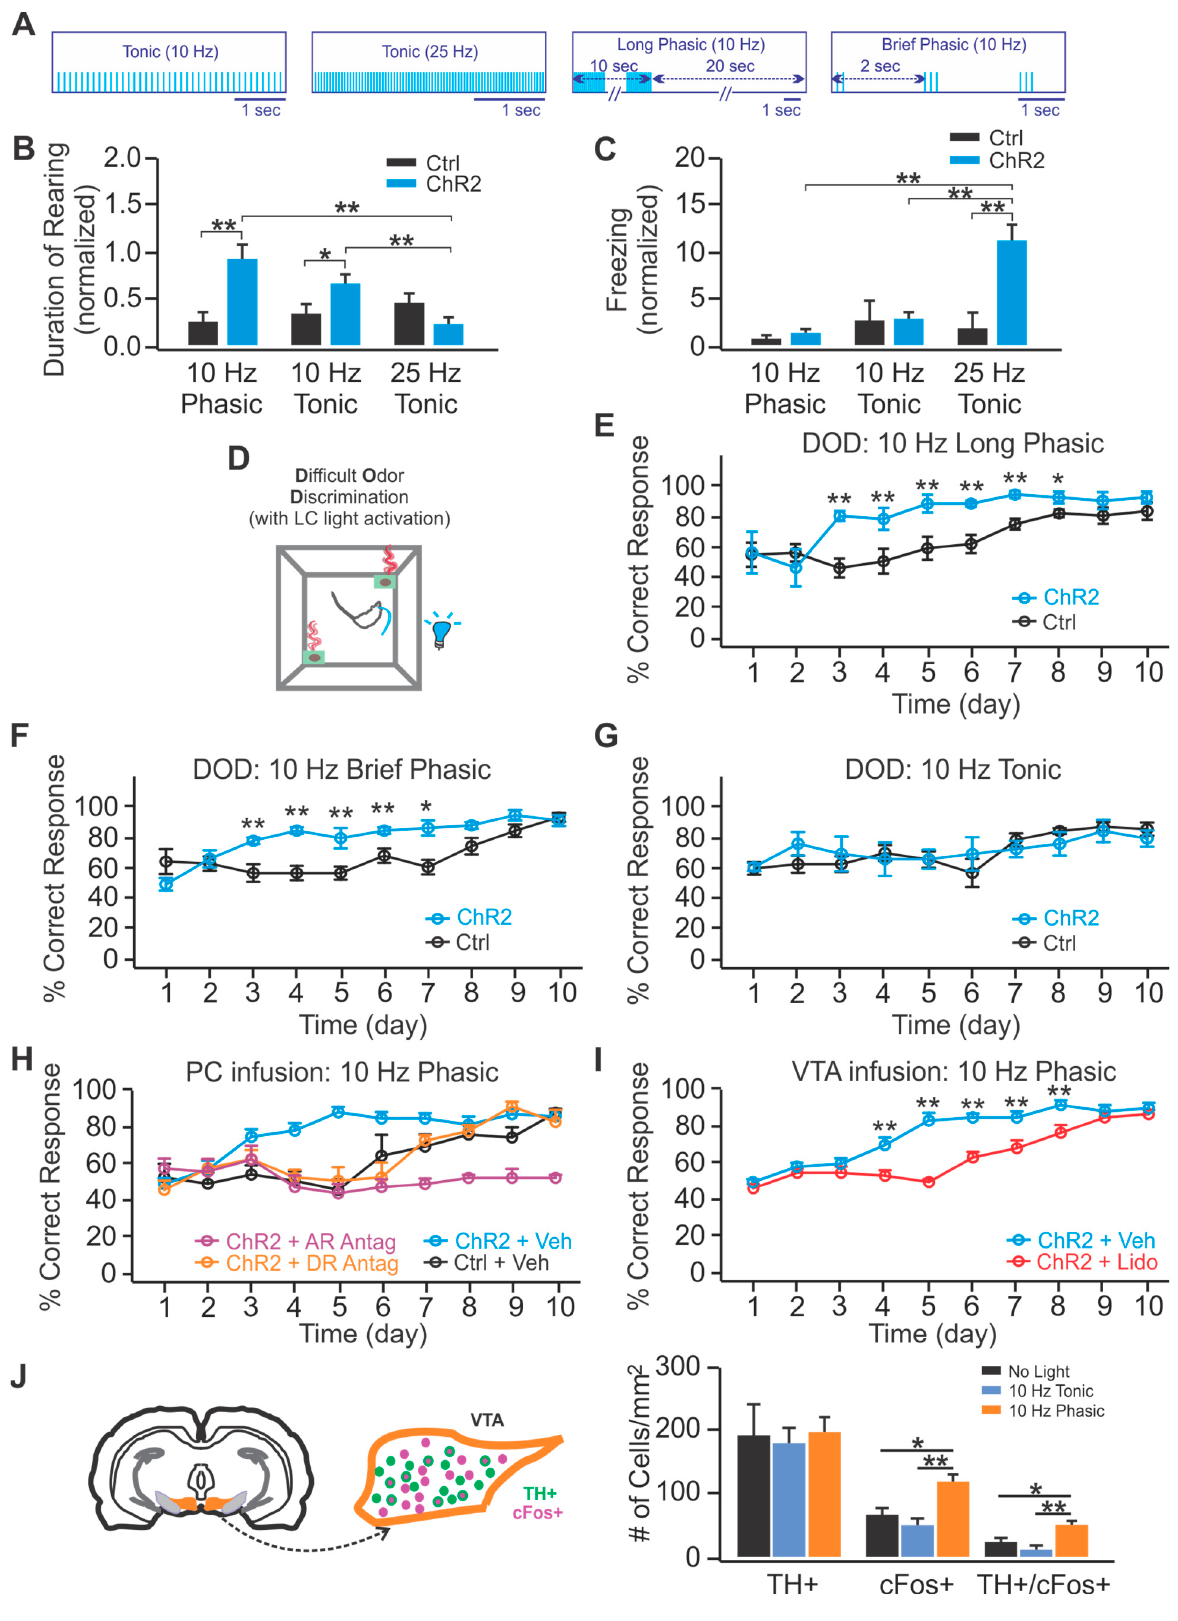
Figure 5. Phasic, but not tonic, LC activation improves odor discrimination learning via selective VTA activation. ( A ) The four blue light pulse patterns used to activate LC neurons. ( B ) Increases in rearing duration during a 10 min open field test with 10 Hz phasic or 10 Hz tonic LC activation relative to controls. ( C ) Increase in open field freezing behavior with 25